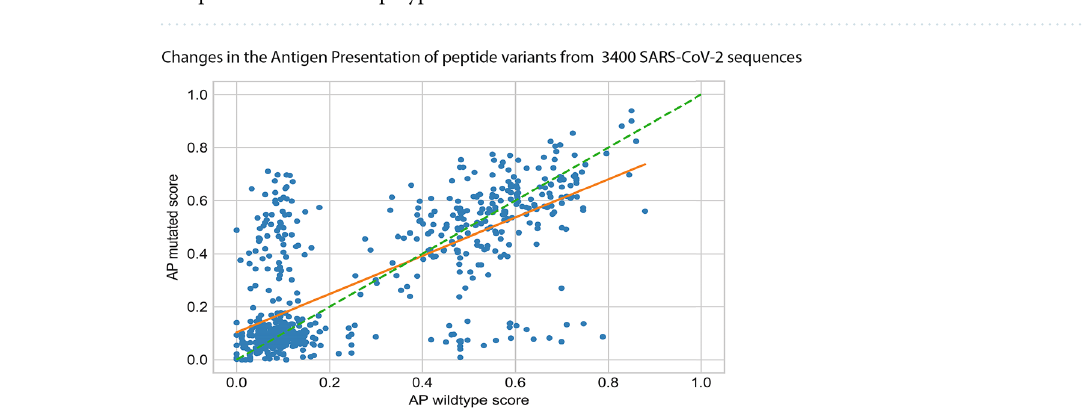
Figure 3. Epitope hotspots from the Monte Carlo analysis are captured across the majority of the entire viral proteome using filtering procedures for conserved and human self-peptides. The most abundant signal for hotspots is in the orf1ab polyprotein.